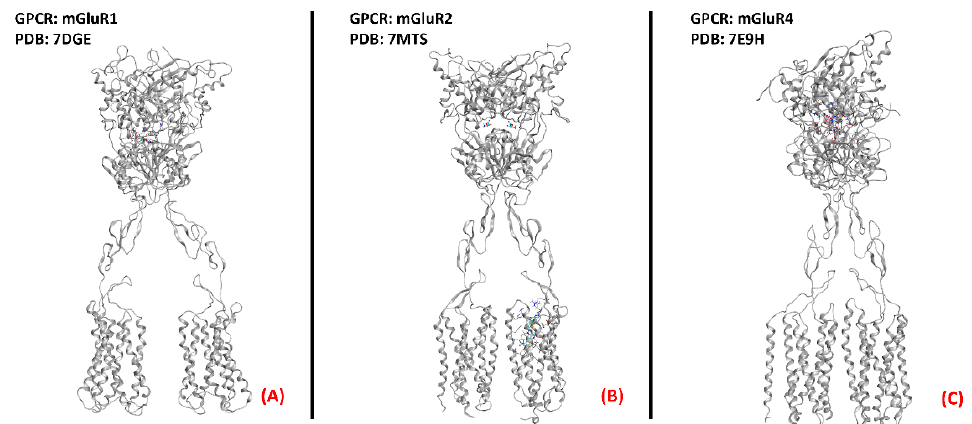
Figure 24. One example of each group of the metabotropic glutamate receptors. ( A ) mGluR1, a member of the first group of mGluRs (sourced from the Protein Data Bank, PDB code: 7DGE [157], method: cryo-EM, resolution: 3.65 Å ), ( B ) mGluR2 (owing to mGluRs group II, sourced from the Protein Data Bank, PDB code: 7MTS [158], method: cryo-EM, resolution: 3.20 Å ), and ( C ) mGluR4, part of group III of the mGluRs (sourced from the Protein Data Bank, PDB code: 7E9H [159], method: cryo-EM, resolution: 4.00 Å ). All of the images were created and rendered with MOE.